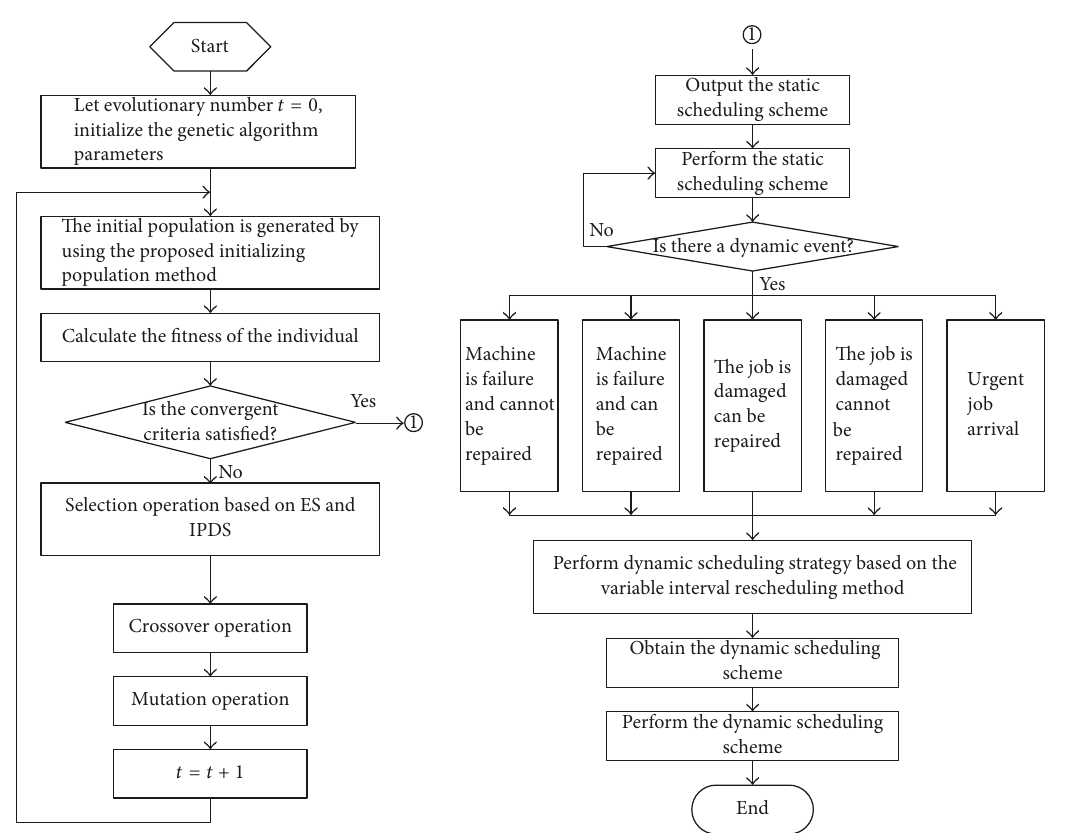
Figure 9: Flow chart of the proposed improved genetic algorithm and dynamic rescheduling strategy.